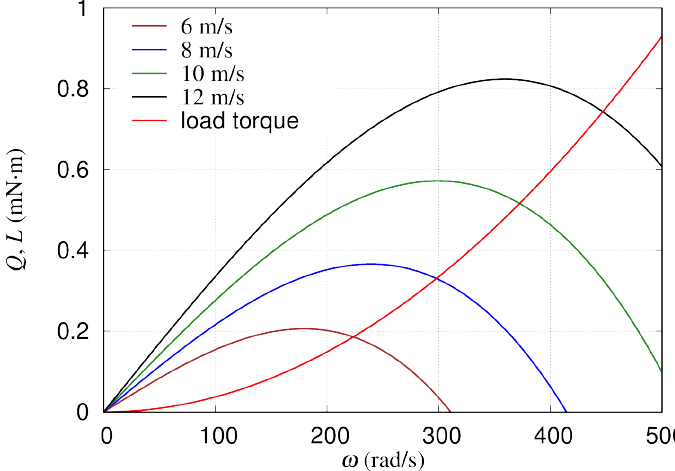
Figure 4. The rotor torques for V = 6,8,10, and 12m/s and load torques are plotted against the angular velocity of the